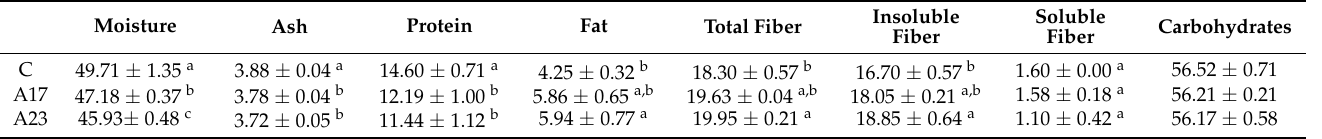
Table 5. Proximate composition: moisture, ash, protein, fat, and fiber (in g 100 g − 1 DW) of the GF breads: (C) control, without apple flour, (A17) with 17%, and (A23) with 23% apple flour addition.